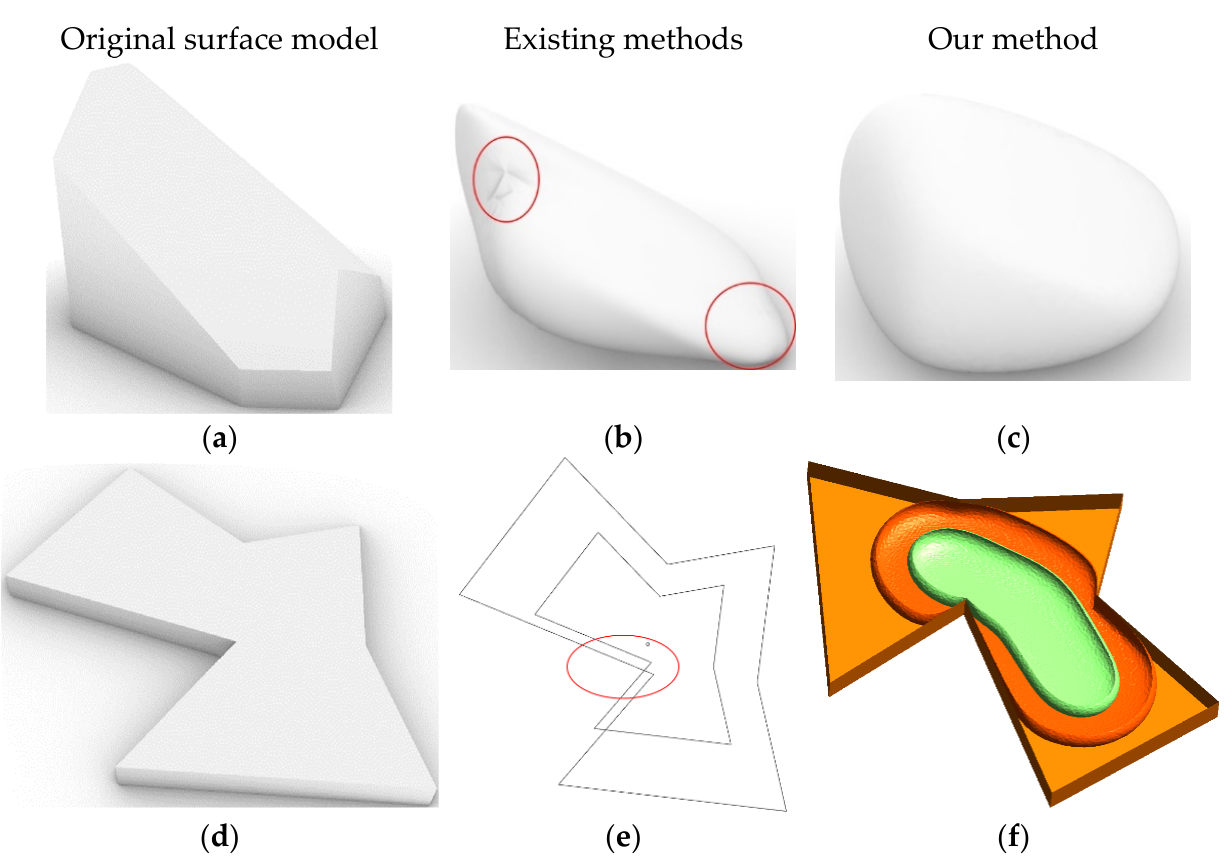
Figure 1. Problems of current 3D porous structure modeling methods and our improvements. ( a ) is a 3D surface model; ( b ) is the generated pore with the subdivision surface algorithm from the convex model ( a ) which leads to stress concentration phenomena; ( c ) is the generated pore from ( a ) with our proposed method; ( d ) is an extrusion surface model; ( e ) is the cross-scaling surface from the concave model ( d ); ( f ) is generated isothermal surfaces from ( d ) with our method. The different colors in ( f ) represent different isothermal surfaces, and the same color means that the geometric units in them have the same temperature.